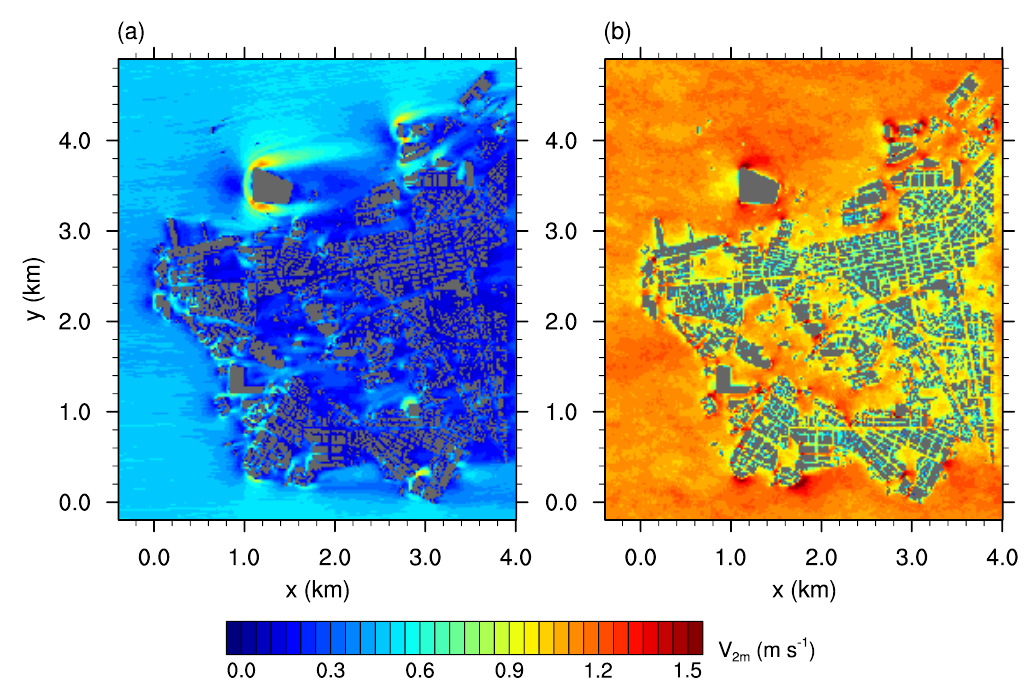
Figure 3. Averaged three-dimensional wind velocity at 2m height for the ( a ) neutral case and ( b ) unstable case. Buildings are shown in gray.